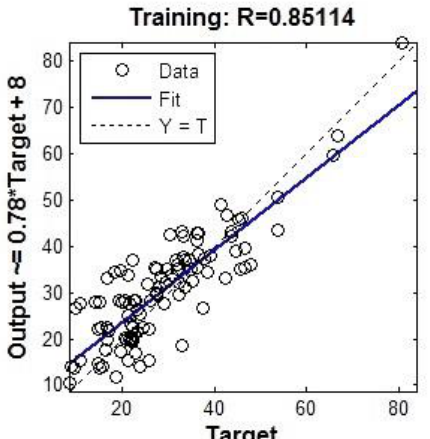
Fig. 15. Relationship between Target and Output Values in Training Step of ANN Modeling with 20 Hidden